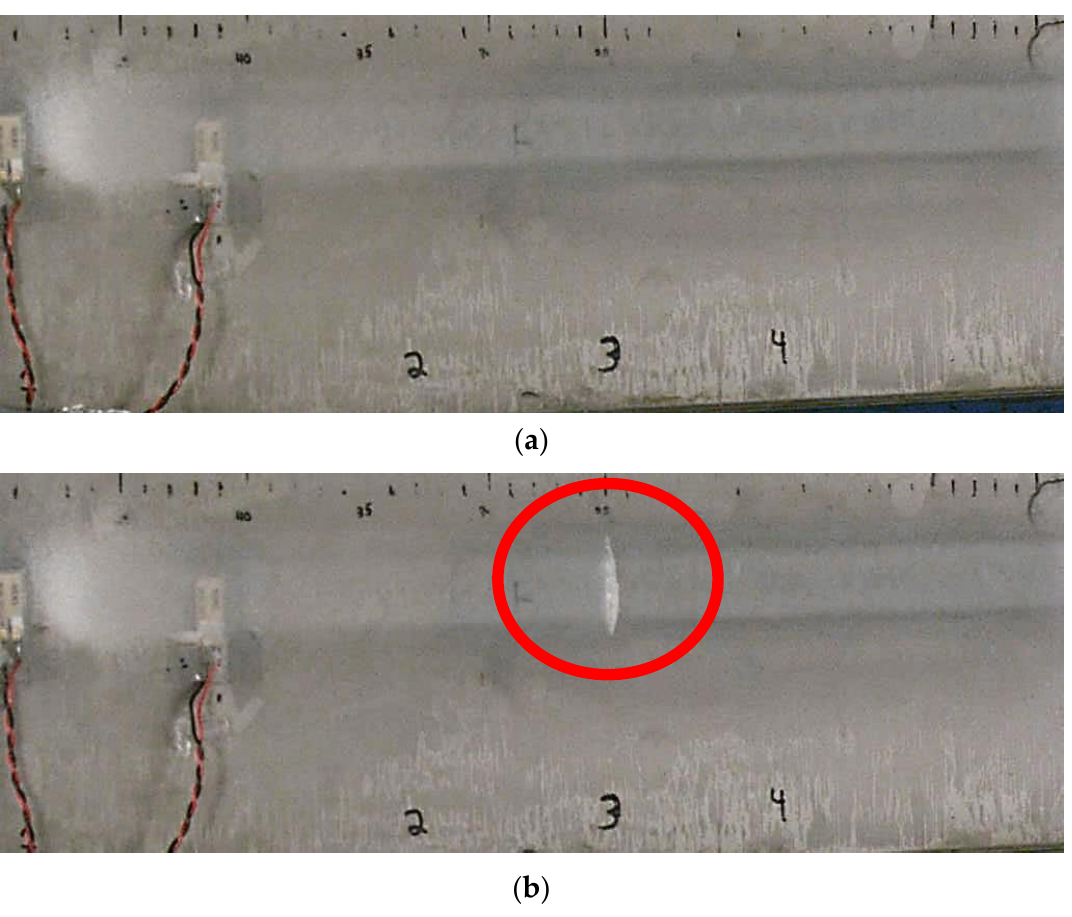
Figure 11. Pictures captured after 43.465 ( a ) and 43.532 s ( b ) with the camera during a frequency sweep from 250 to 500 Hz in 60 s with the five actuators activated in phase at 600 Vpp.